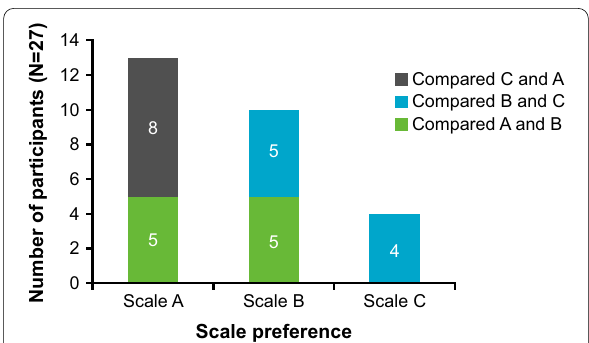
Fig. 5 Stage 1 participant preference for scale A (simple faces), scale B (circles of decreasing size), or scale C (squares of decreasing quantity). Each bar illustrates the number of children who preferred the scale denoted, whilst the color represents the scale it was being compared